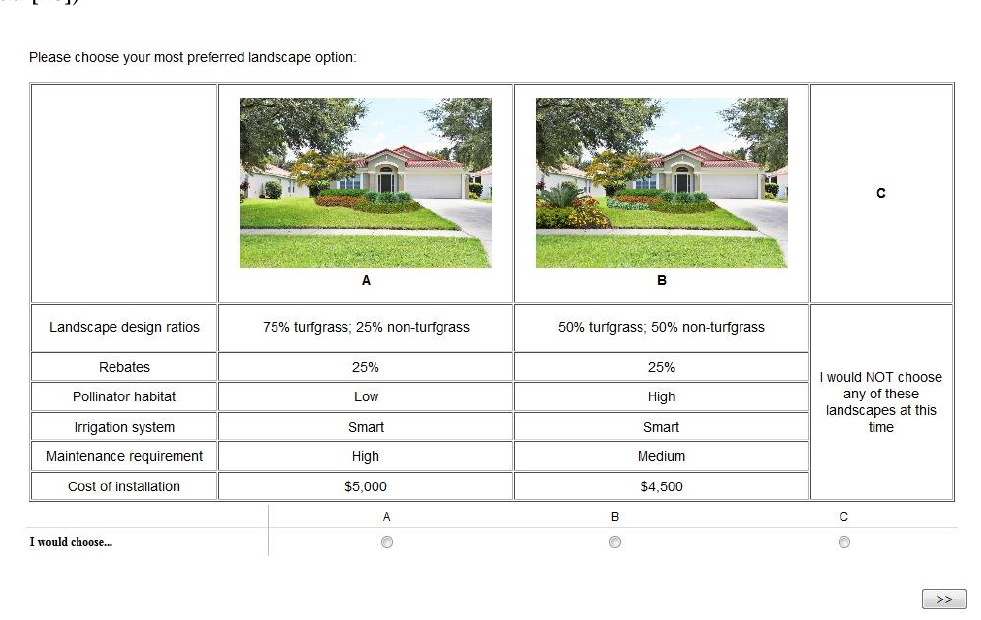
Figure 1. Choice scenario example.